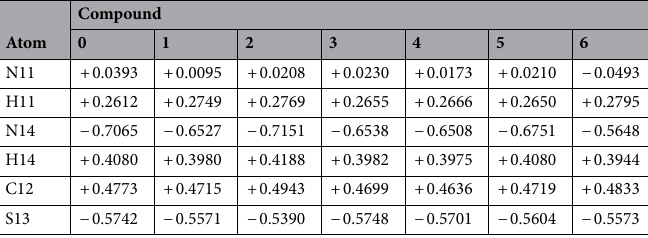
Table 7. CHelpG charges of selected atoms of compounds 0 and 1 – 6 .